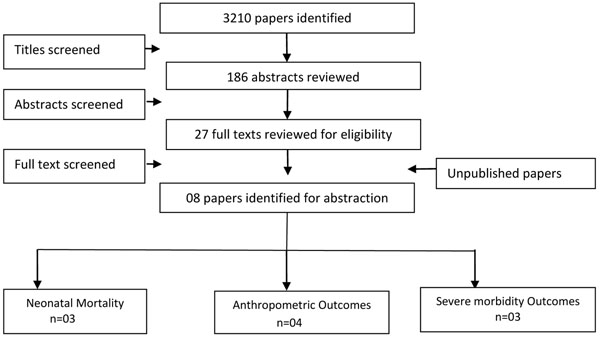
Search flow diagram